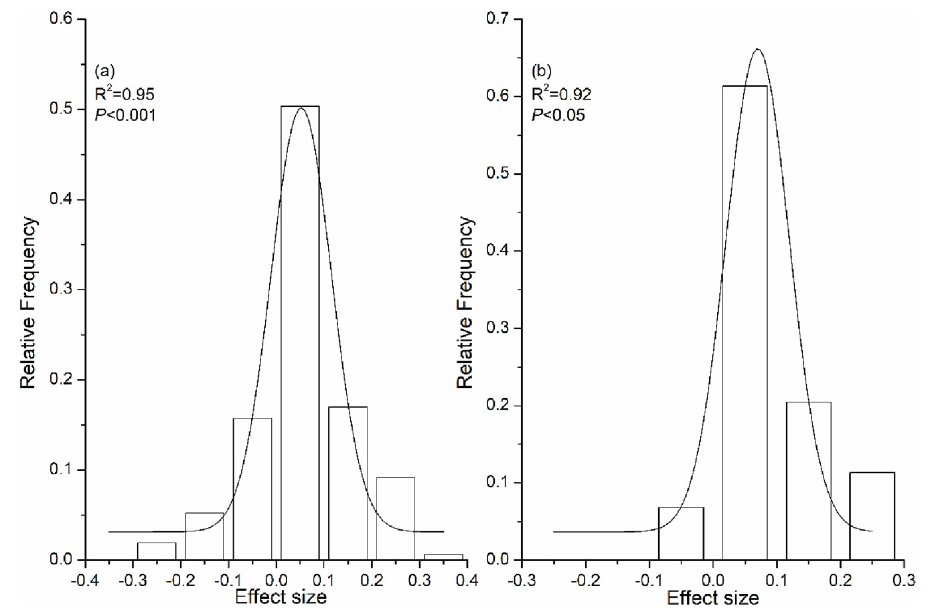
Fig 2. Frequency distribution of effect sizes for yield (a), and WUE (b) responding to crop residue return compared to no-straw. Solid lines are fitted normal (Gaussian) distributions of frequency data sets.